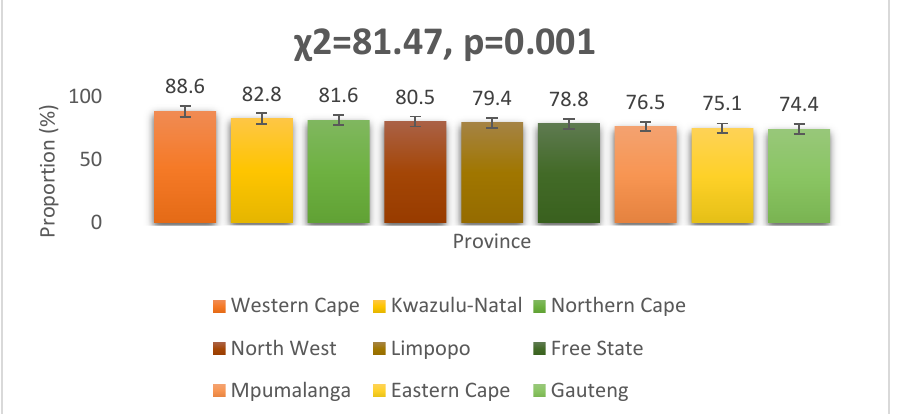
Figure 2. Utilization of Antenatal care by women of reproductive age in SA stratified by province. Women in the poverty band of the wealth index were the majority (41.3%), those in the middle wealth index were 22.8% and barely one-third belonged to the rich band (35.9%). The majority were not employed (69.4%), and 77.1% neither owned a car, a motorcycle/scooter (98.4%), nor a bicycle (85.8%). A little over half owned a refrigerator (58.93%), and most had electricity (71.6%). Barely two-thirds owned a television (68.89%), a radio (65.29%), watched TV every day/week (63.6%), and listened to the radio every